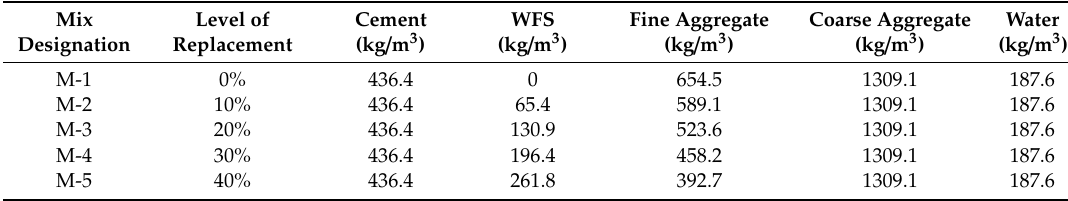
Table 4. Mix proportions containing